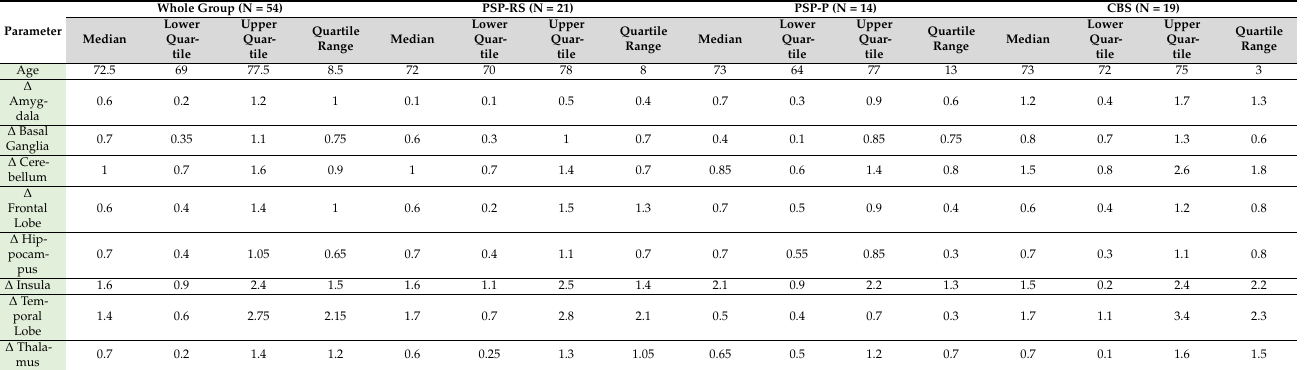
Table 1. Descriptive